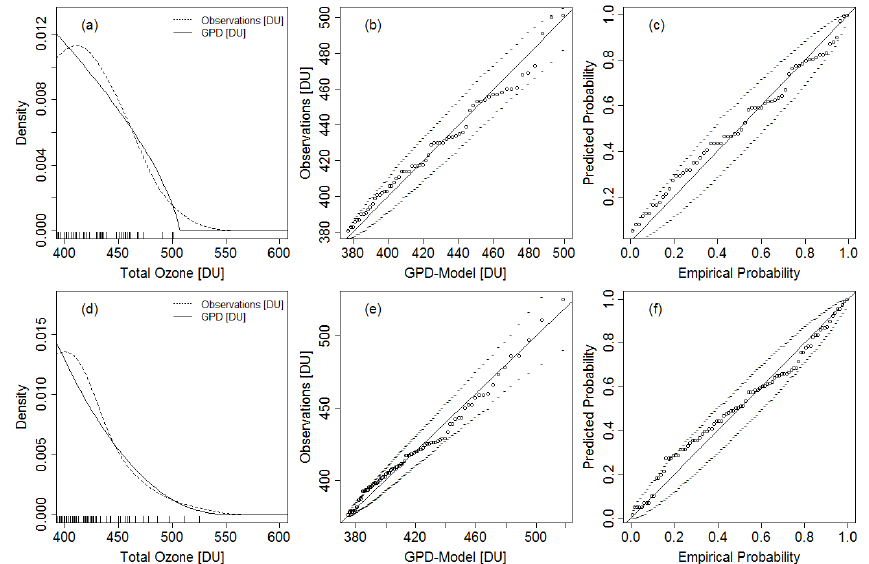
Fig. 7. (a) Tail density plot of observations and GPD for high total ozone with too low threshold values ( u = 377DU), (b) Quantile-Quantile- comparison between observed and GPD-model predicted extreme values, (c) empirical and predicted probability for these events (all three for the month of March in 1927–1959). (d–f) same as (a–c) but for period 1960–2008 with u = 375DU. In (b–c) and (e–f) dotted lines represent the 95% confidence intervals, straight lines give the identity